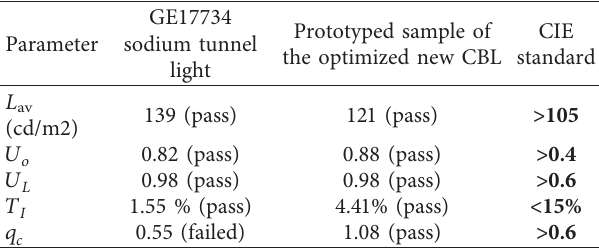
Figure 15: The measured intensity distribution of the GE17734 CBL (General Electric Co. Ltd.) with the 400W sodium lamp. Table 3: Comparison of the lighting performance between the GE17734 sodium tunnel light and the optimized new